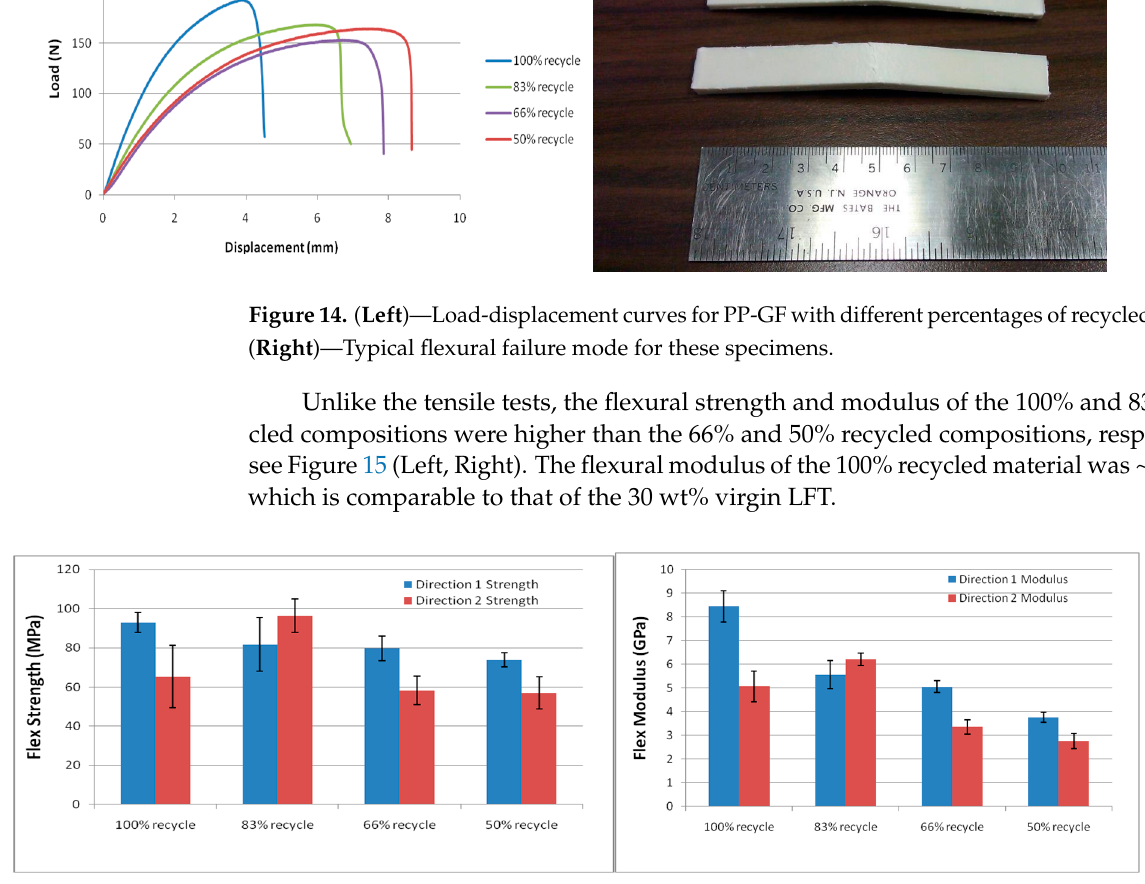
Figure 15. Flexural response of PP-GF with different percentage of recycled content; ( Left )—Flexural strength (Mpa); ( Right )—Flexural modulus (Gpa). In total, 100% recyclate is the as-received PP-GF scrap.